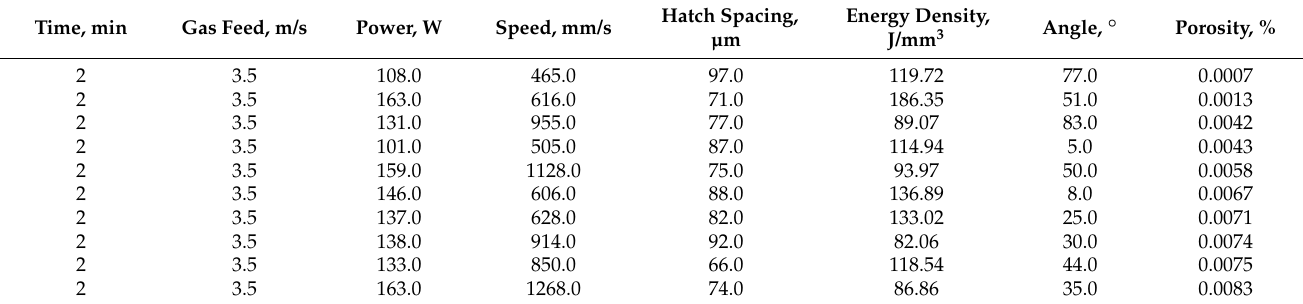
Table 3. Empirically obtained process parameter configurations sorted by lowest porosity.